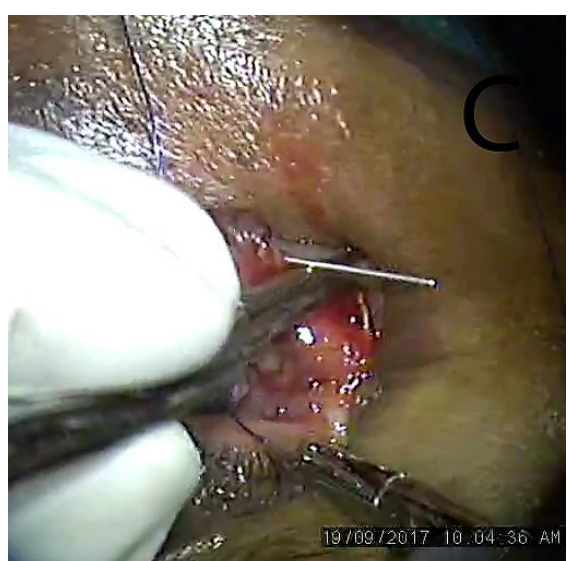
Figure 3: Blunt end of the needle brought out of the proximal lacerated end